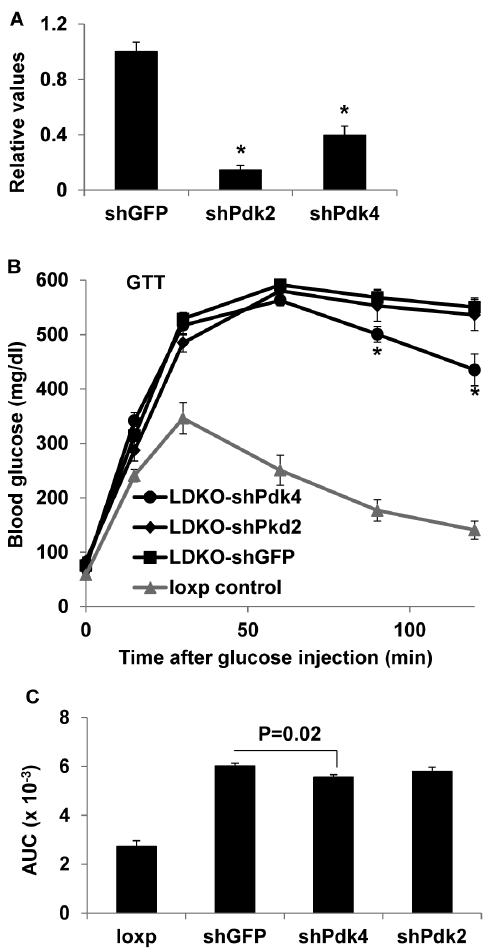
Figure 6. Hepatic Pdk4 knockdown moderately improves glucose tolerance in IrsLDKO mice. A, Gene knockdown efficiency was analyzed by real-time PCR in IrsLDKO livers transduced with shRNA adenoviruses against GFP (shGFP), Pdk2 (shPdk2), or Pdk4 (shPdk4). B, Glucose tolerance tests were performed in shRNA adenoviruses infected IrsLDKO mice. C, Area under curve analysis (AUC) was performed for the above glucose tolerance test data. Data are presented as means 6 SEM, n=4–5. *, P , 0.05 relative to corresponding